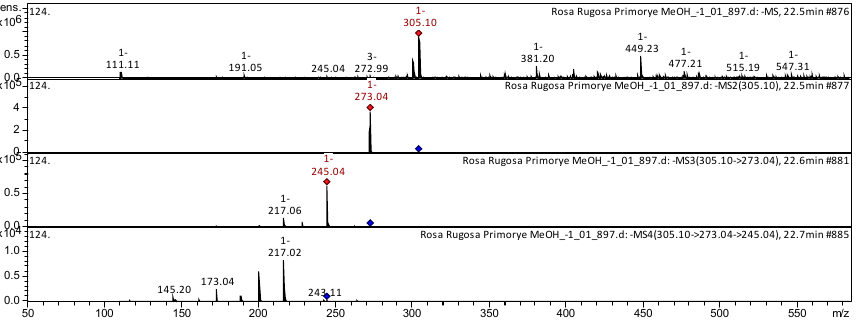
Figure 9. CID-spectrum of Gallocatechin from R. rugosa , m / z 305.10.